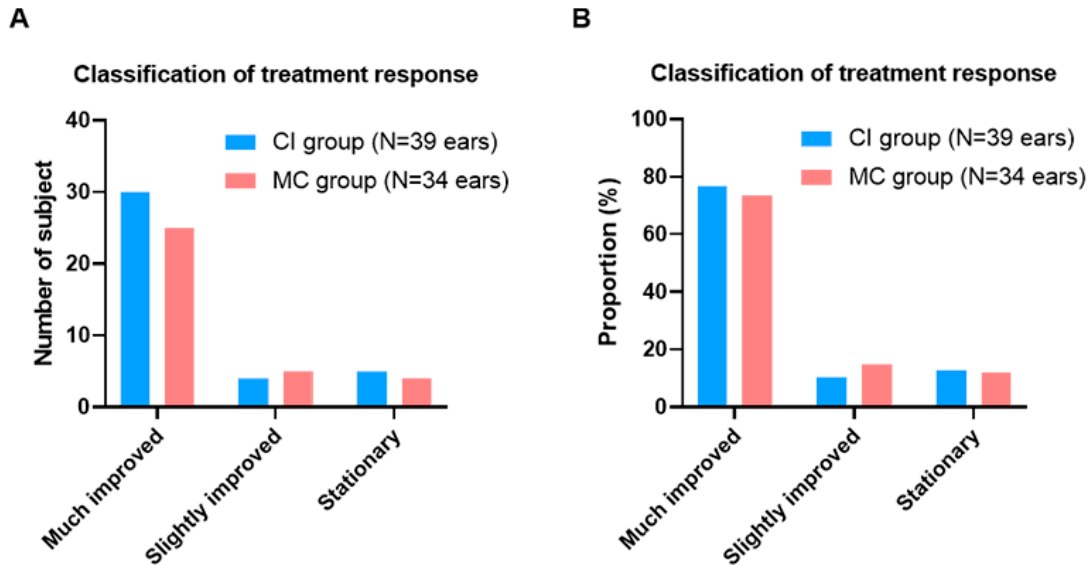
Figure 4. Classification of treatment response with reference to subjective improvement of itching sensation between the two groups. ( A ) Among the 39 ears in the CI group, 30 (76.9%), 4 (10.3%), and 5 (12.8%) met the criteria for “much improved”, “slightly improved”, and “stationary”( B ) The proportion of patients with “rebound” was 3 (10.0%), 2 (50.0%), and 3 (60.0%) in the “much improved”, “slightly improved”, and “stationary” groups CI, topical calcineurin inhibitor; MC, moisturizing cream.